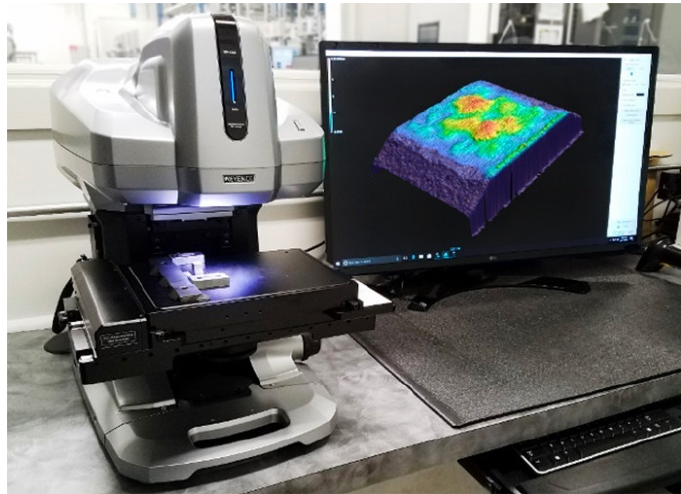
Figure 2. Confocal microscope with laser 3D scanning type Keyence VK-X 1050.